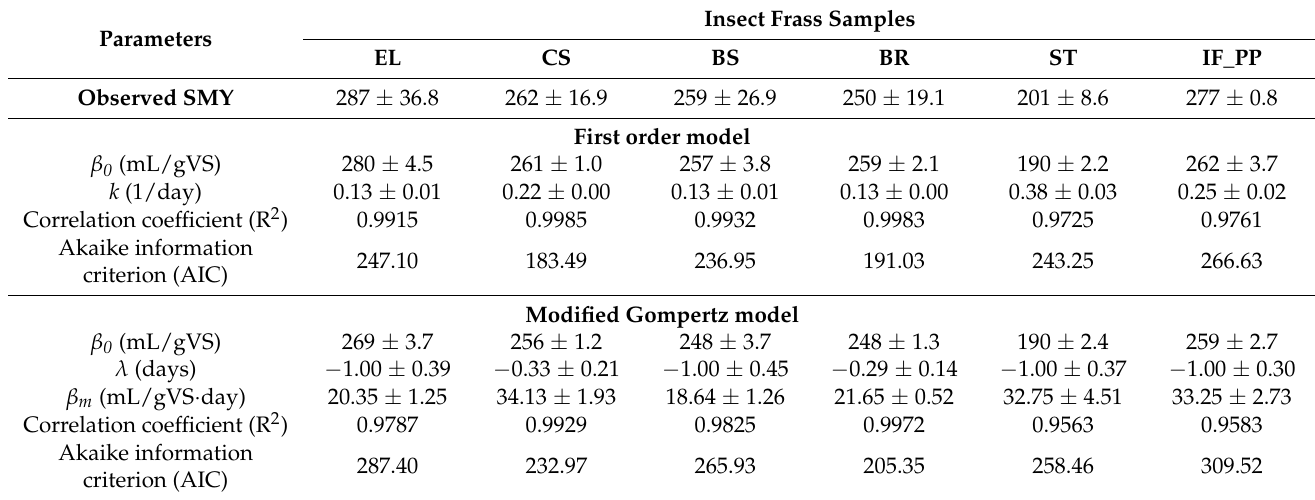
Table 3. Estimated parameters for the insect frass samples: Elodea nutallii (EL), corn silage (CS), brewers spent grain (BS), bran (BR), stillage (ST), and insect frass (IF_PP) for the first-order model and modified Gompertz